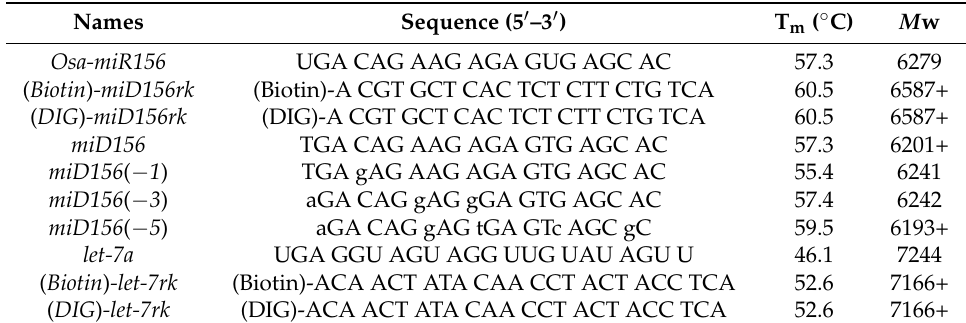
Table 1. MicroRNAs (miRNAs) and derived Oligo-miD and Oligo-miD probe sequences used in liquid hybridization and solid phase detection